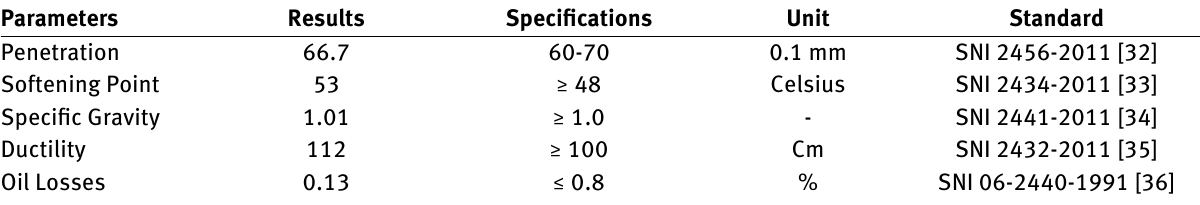
Table 2: The 60/70 penetration grade asphalt test results